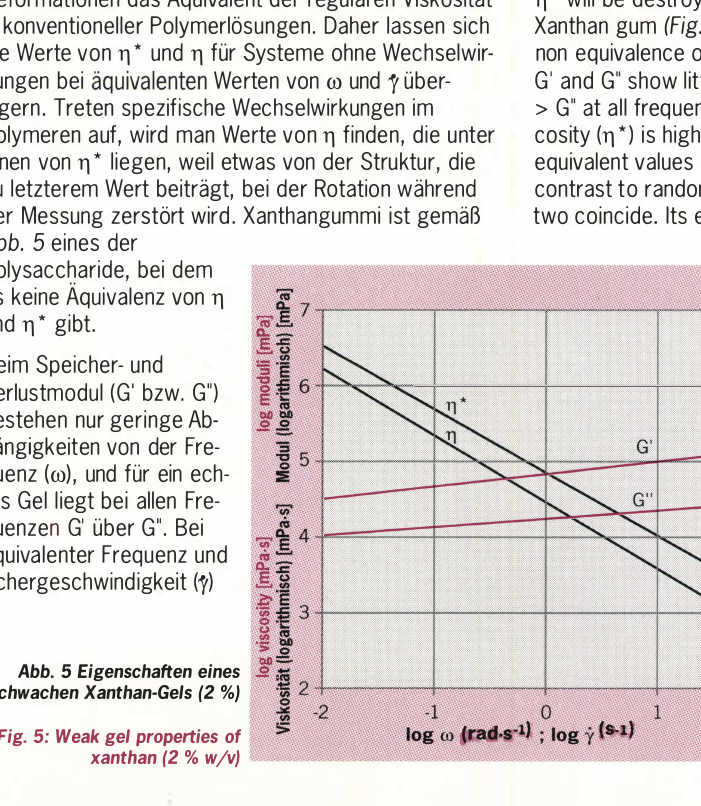
Fig. 5: Weak gel properties of xanthan (2 %